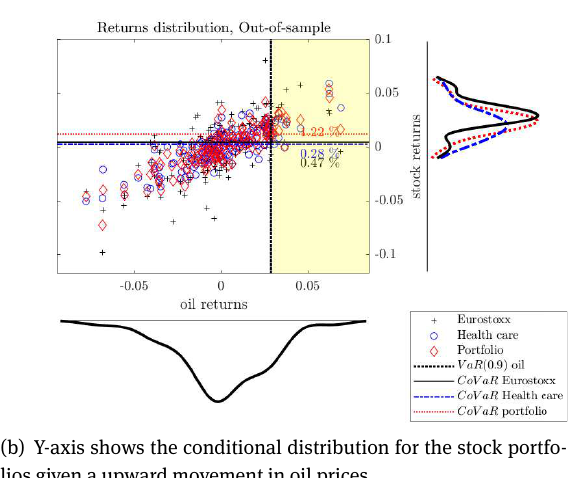
(b) Y-axis shows the conditional distribution for the stock portfo- lios given a upward movement in oil prices